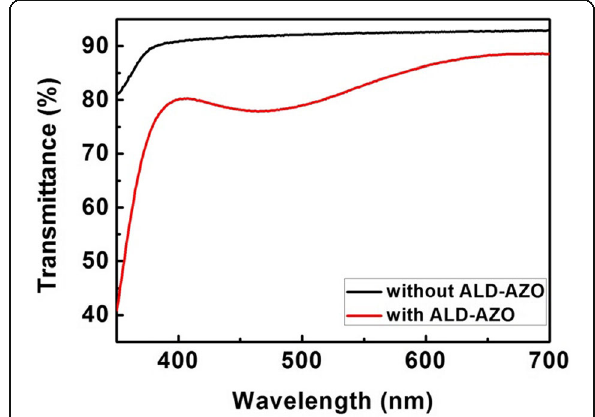
Fig. 5 The transmittances of the PAD-AZO films and the two-step AZO